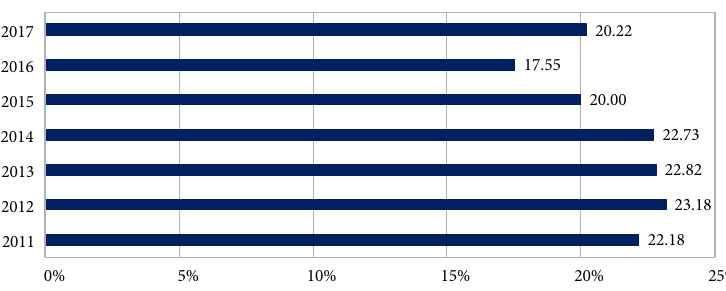
Fig. 2. Acceptence ratios of the submitted manuscripts in 2011–2017